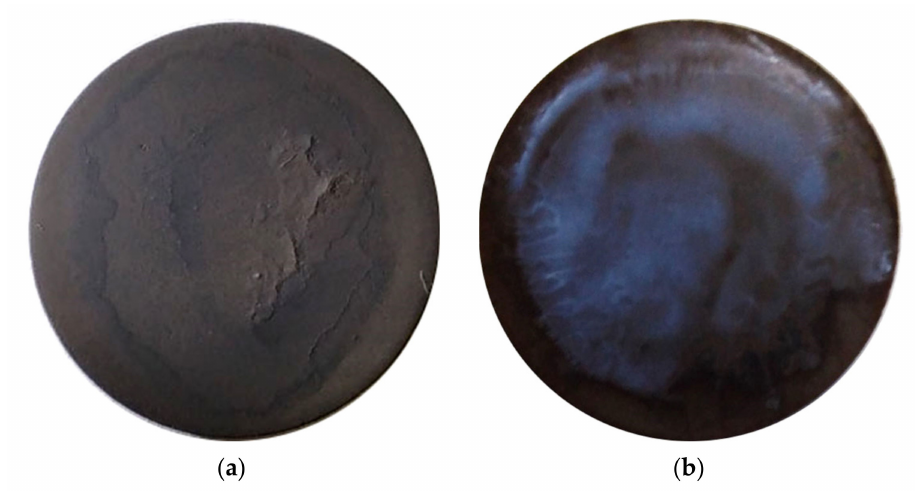
Figure 8. Optical photographs of EPD deposits obtained by direct deposition on porous NiO-SDC cermet substrates from the suspensions based on powders: ( a ) BCZYYbO-CuO; ( b )